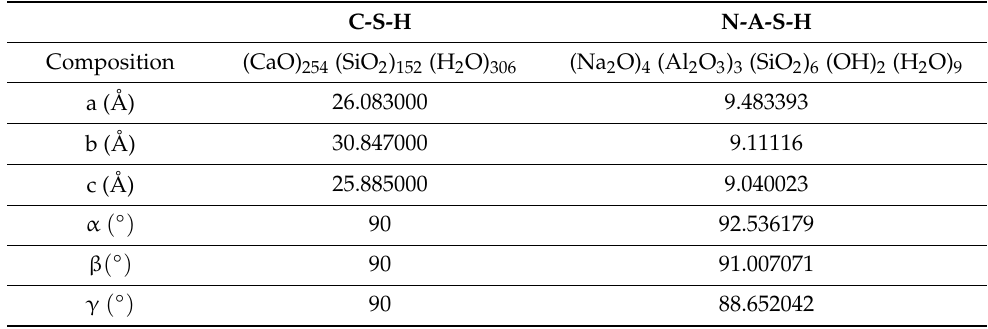
Table 2. Stoichiometry and lattice constants and angles of the studied C-S-H and N-AS-H structures.